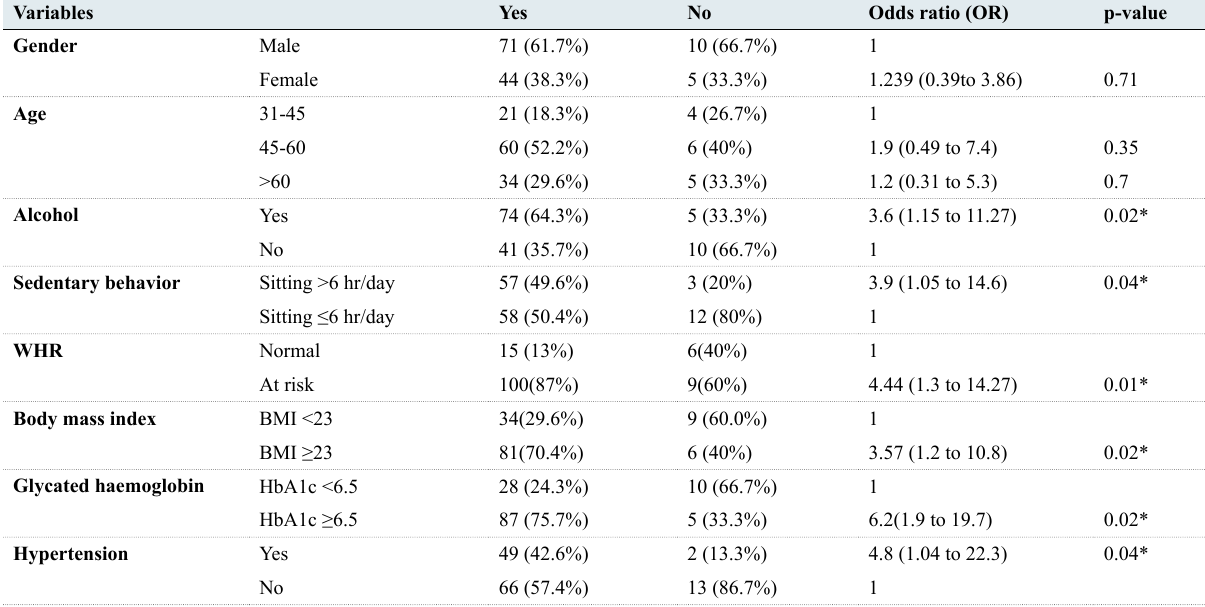
Table 2:Factors associated with dyslipidemia in T2DM